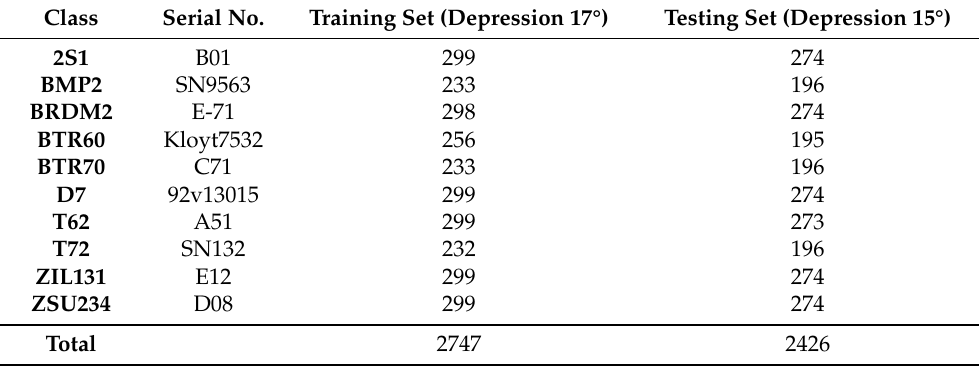
Table 1. Data description for SOC.